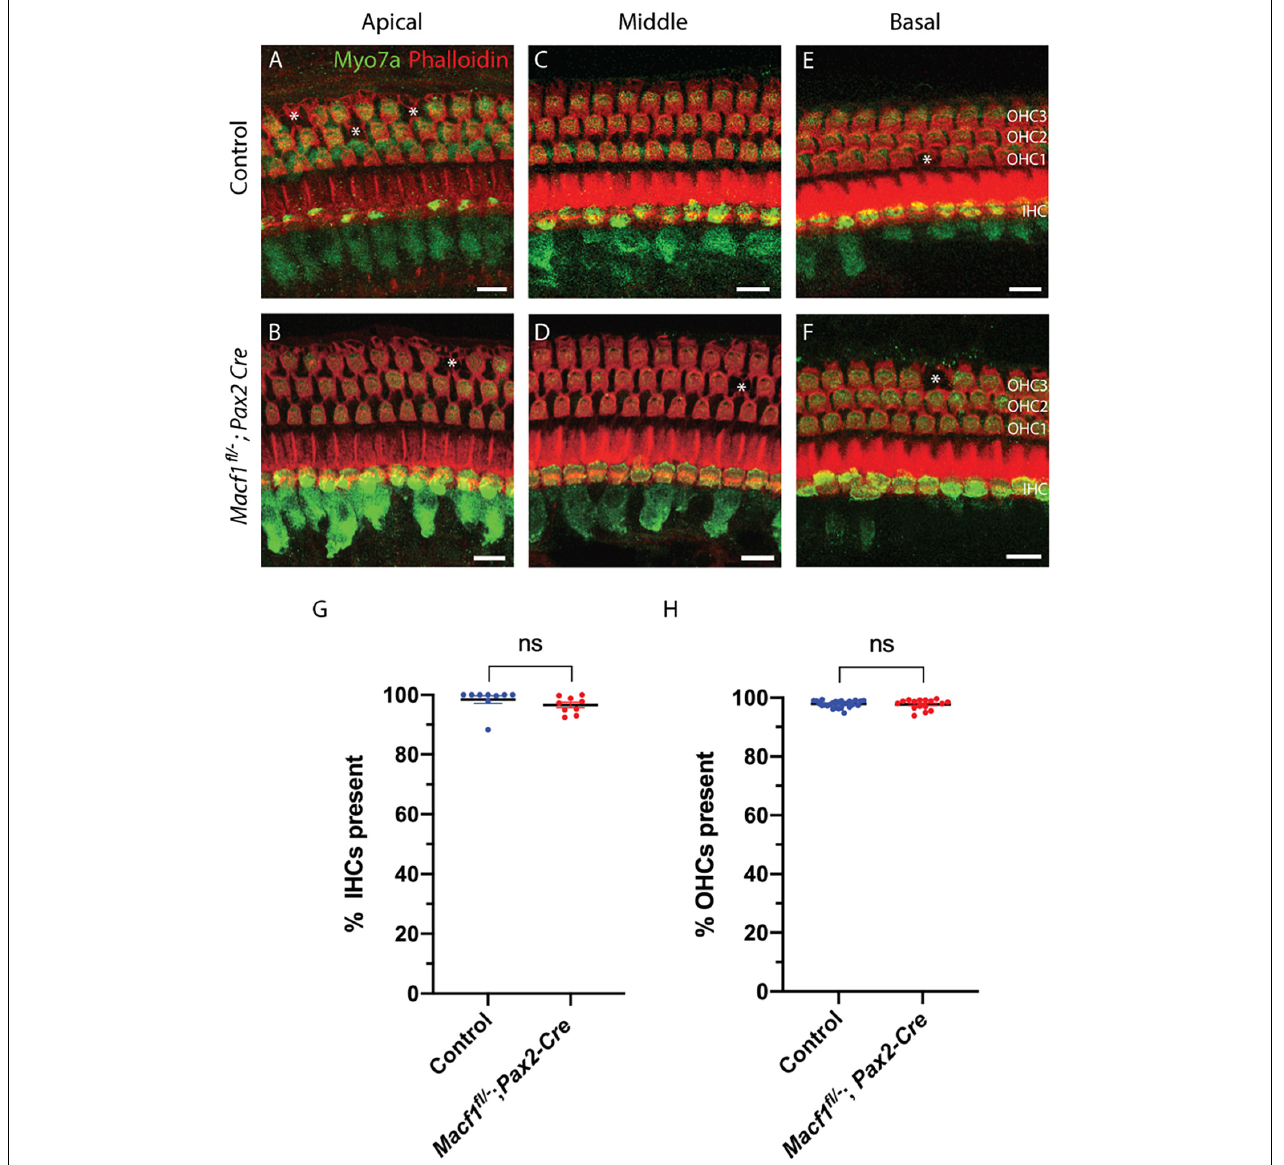
FIGURE 2 | Hair cell viability is not impacted by conditional ablation of Macf1 . (A,C,E) Micrographs of cochlear hair cells of control animals along apical (A) ( Macf1 fl / + ; Pax2-Cre ), middle (B) ( Macf1 fl / − ), and basal (C) ( Macf1 fl / − ) segments of the organ of Corti. (B,D,F) Images of cochleae from conditional knockout animals along the apical, middle, and basal segments. Myosin7a and phalloidin localization displayed in green and red, respectively. Each missing outer hair cell is indicated by an asterisk. (G,H) Mean percentages ± SEM of inner (G) ( p = 0.26, n = 9 cochleae from 7 Macf1 fl / − mice, n = 9 cochleae from 6 Macf1 fl / - ; Pax2-Cre mice) and outer (H) ( p = 0.76, n = 26 cochleae from 18 Macf1 fl / − mice, n = 16 cochleae from 11 Macf1 fl / - ; Pax2-Cre mice) hair cells present. Each data point represents one cochlea. Scale bar = 10 µ